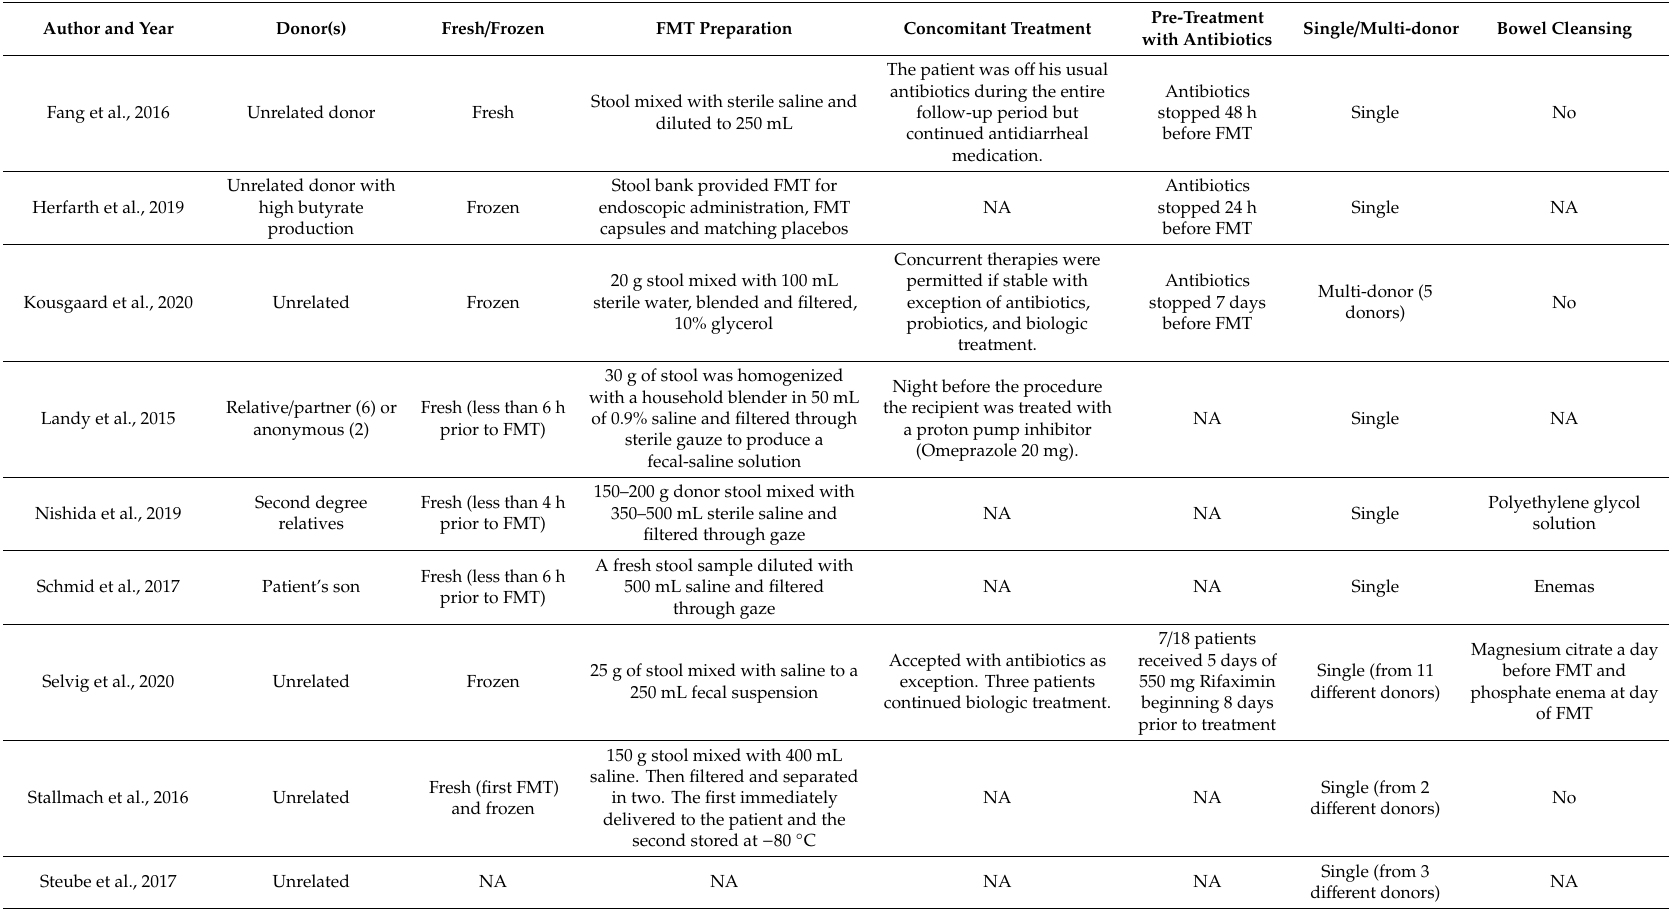
Table 3. Preparation and delivery of FMT